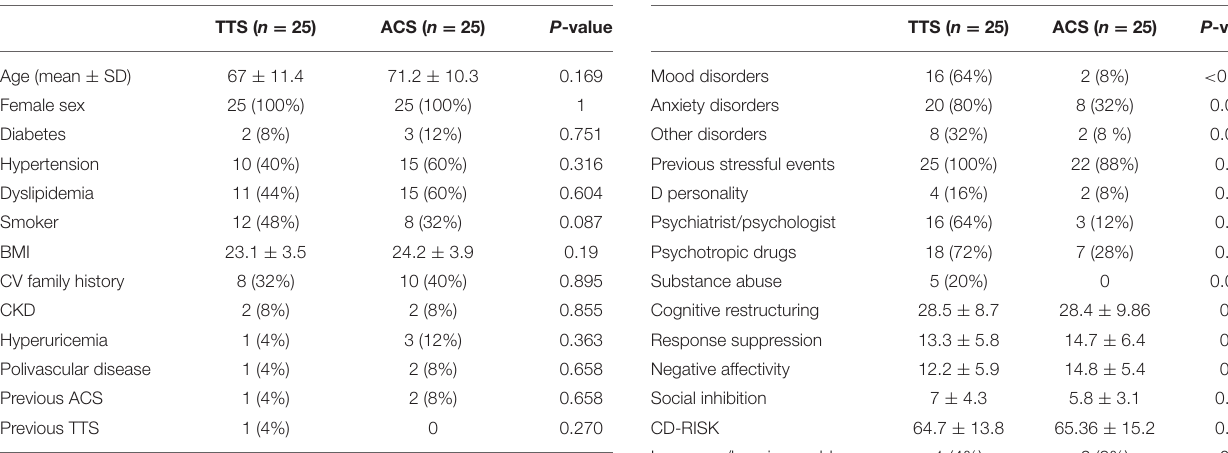
TABLE 1 | Clinical features of TTS and ACS patients. TABLE 2 | Psychiatric features of TTS and ACS